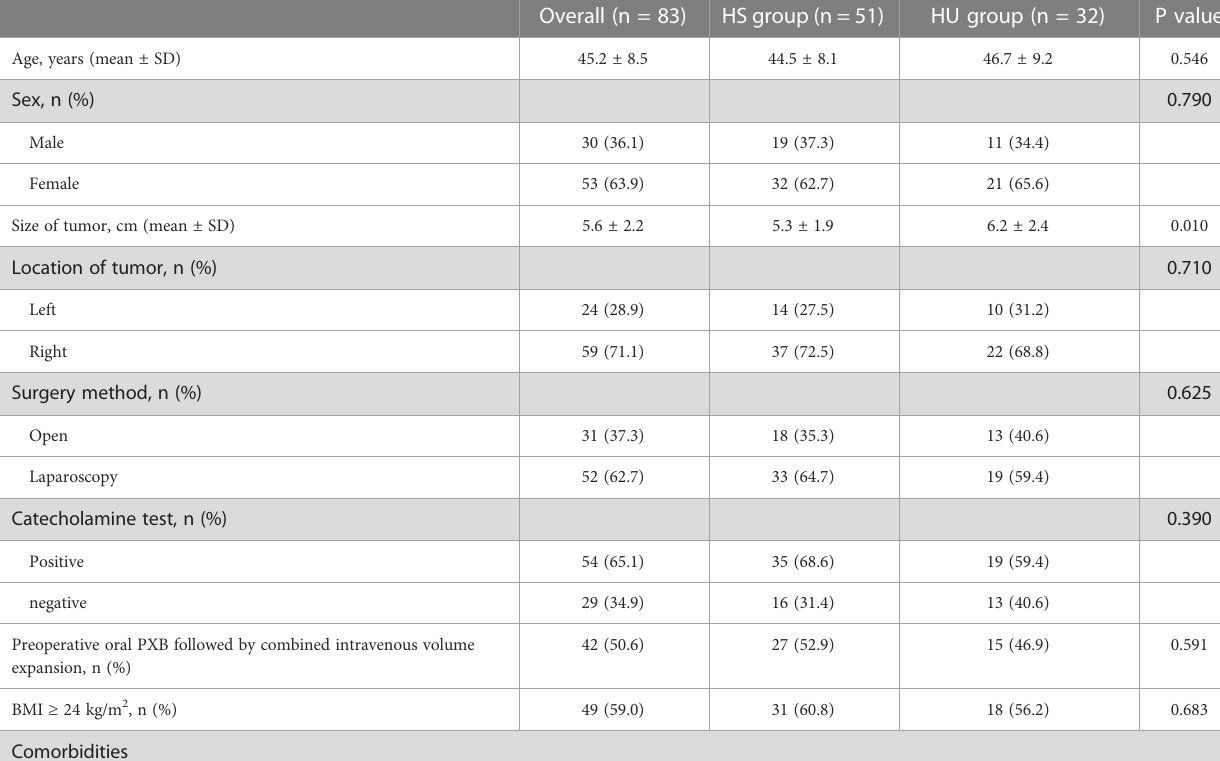
TABLE 1 Clinical characteristics of patients with adrenal pheochromocytoma.